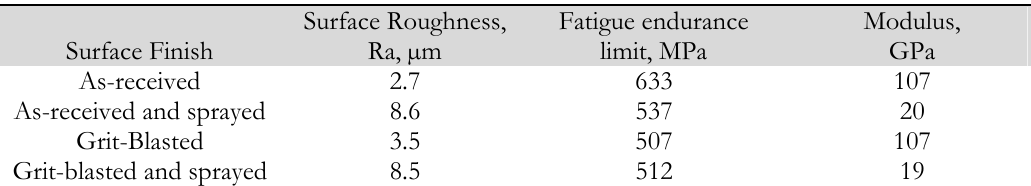
Table 2: Effect of surface finish on fatigue endurance limit [56].